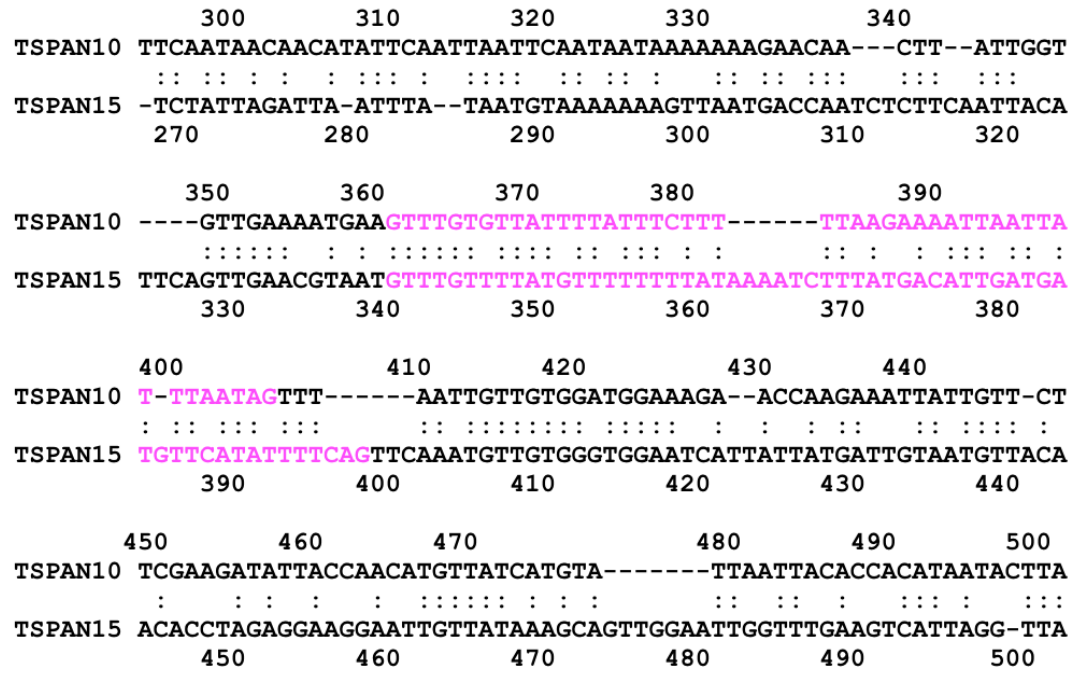
Figure 4. Local alignment of nucleotide sequences between TSPAN12 and TSPAN13 in E. histolytica . Letters in magenta represent intron sequences.